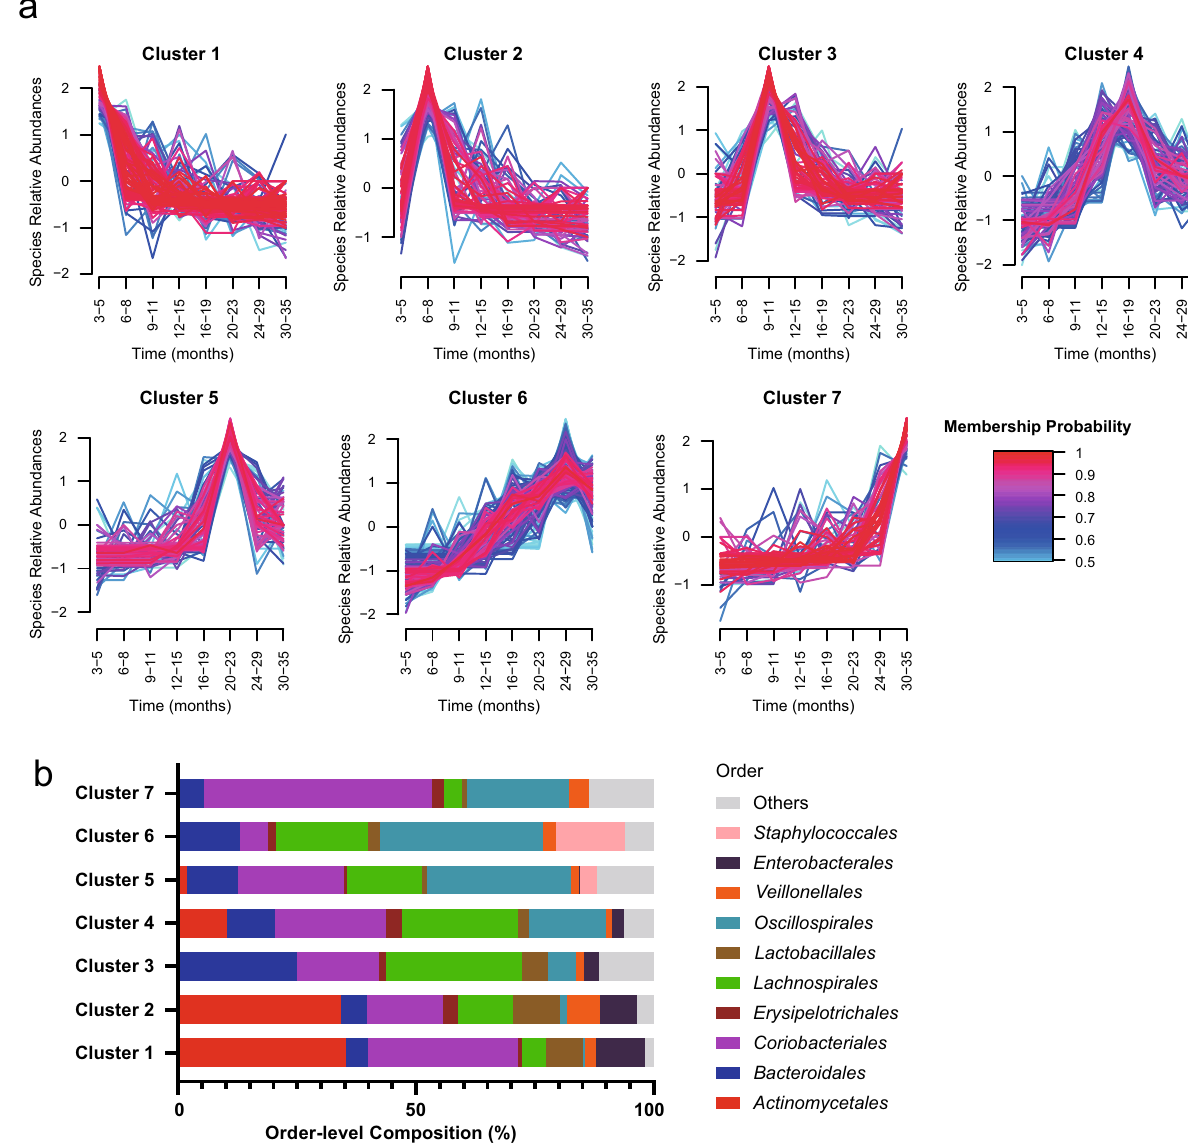
Fig. 2 Genome-resolved longitudinal abundance pro fi les of TEDDY microbiomes. a Species clustered into seven groups by their average MAG abundances across eight developmental stages, shown in months on the x-axis. Clusters are ordered temporally by their peak abundances in the developmental stages from month 3 to month 35. Line colors indicate the membership probabilities of the species. Only species with a membership probability greater than 0.5 are shown. Abundances were standardized to a mean value of zero and a standard deviation of one. b Order-level composition of species identi fi ed in the seven clusters. Source data are provided as a Source Data fi